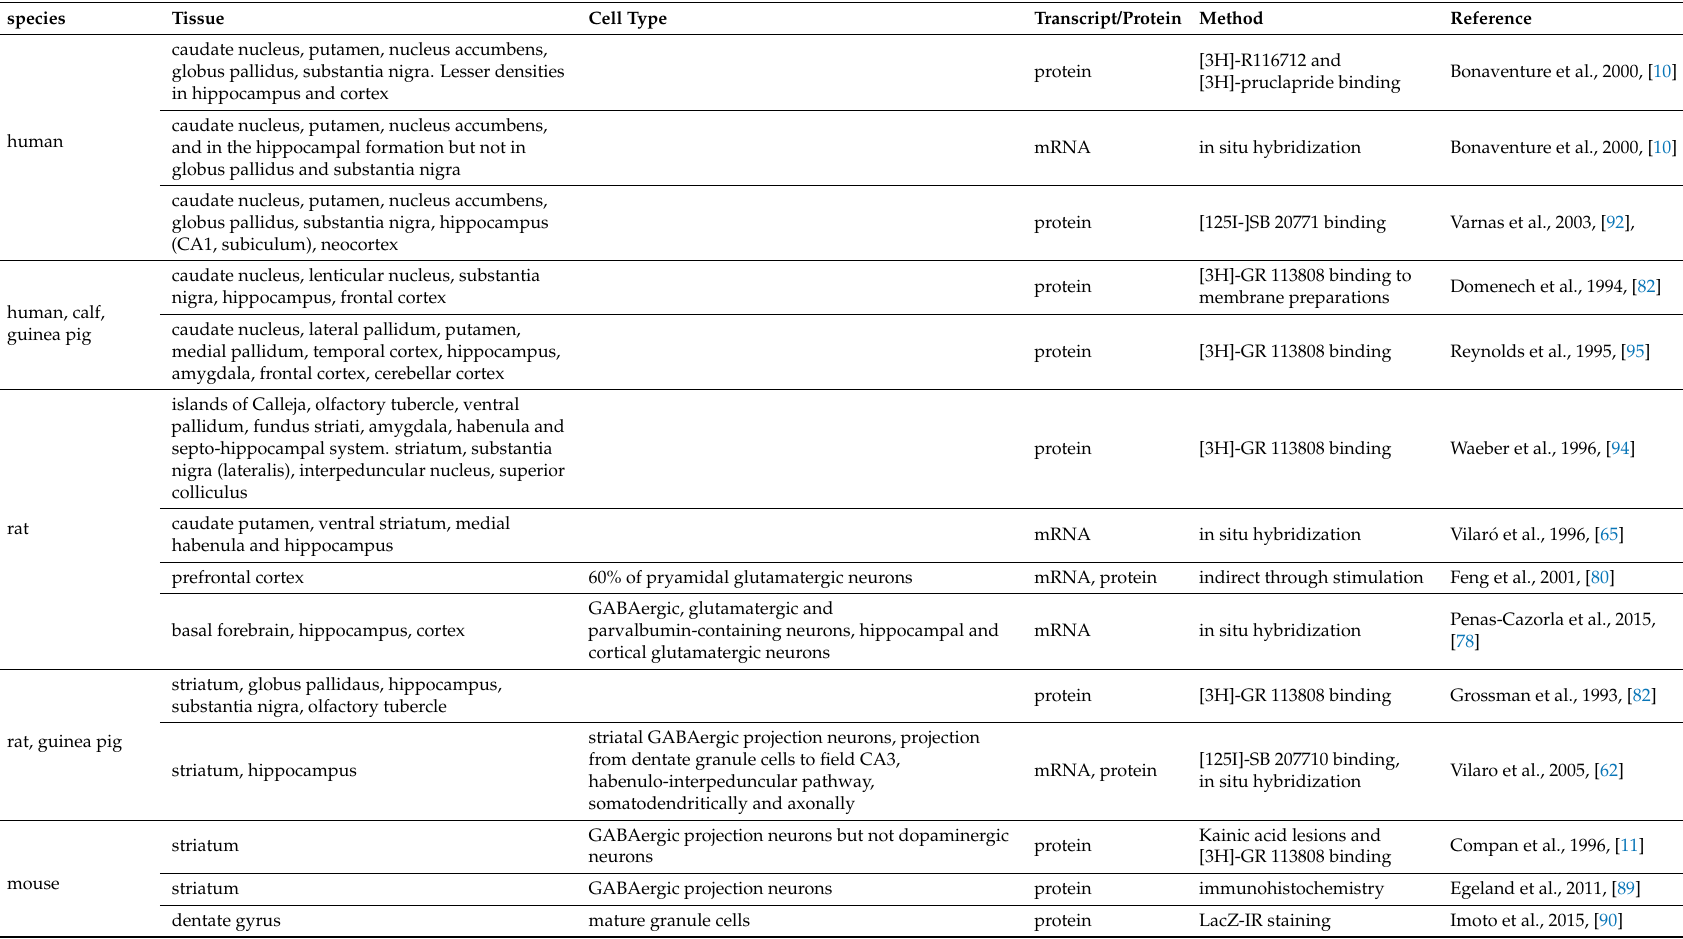
Table 1. Compilation of studies of expression of the 5-HT4 receptor in human, mouse and rat brain in the basal/healthy